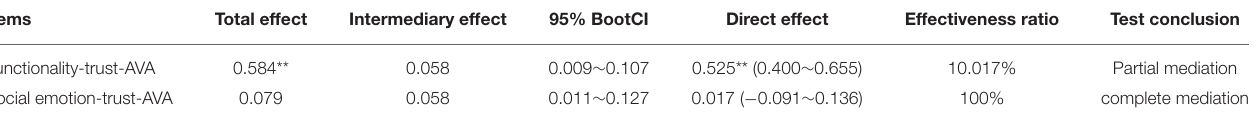
TABLE 8 | Summary of intermediary role test